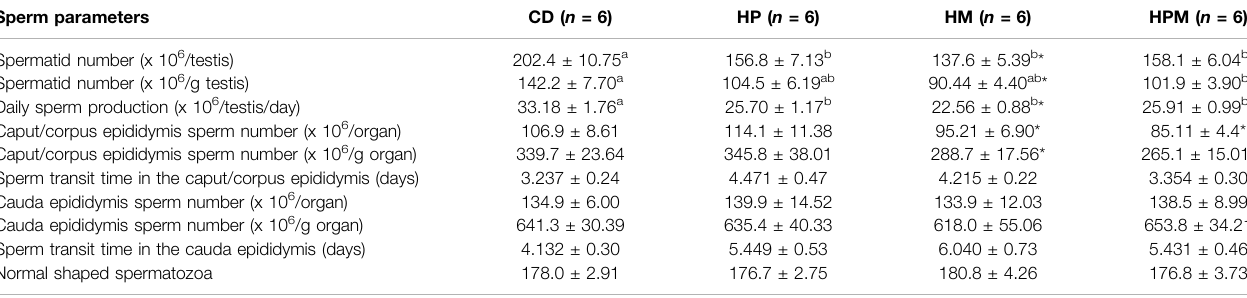
TABLE 2 | Sperm parameters in testis and epididymis in male rat offspring from progenitors fed on high-fat and high-sugar diet. Sperm parameters Spermatid number (x 10 6